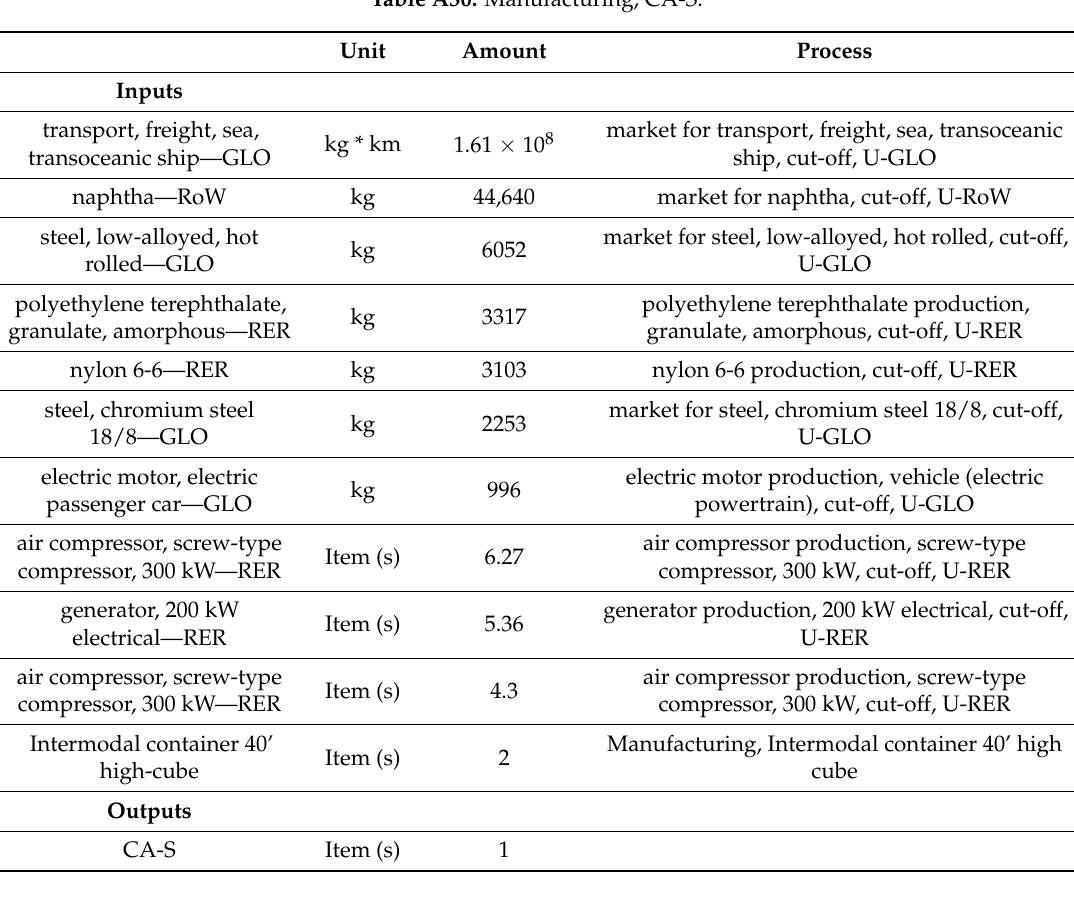
Table A30. Manufacturing, CA-S.